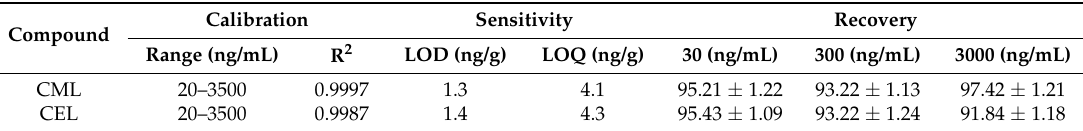
Table 1. Calibration, sensitivity and recovery in